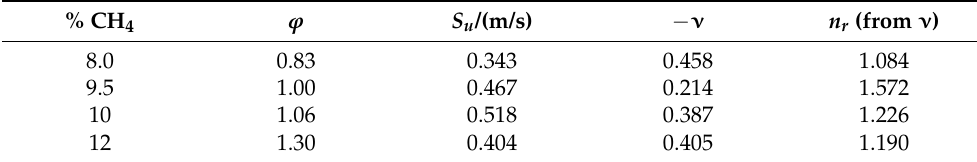
Table 1. Experimental normal burning velocities, S u , baric coefficients of normal burning velocity, ν , overall reaction orders n r resulted from S u , variation with methane concentration ( ϕ is the equivalence ratio), at P 0 = 100 kPa.